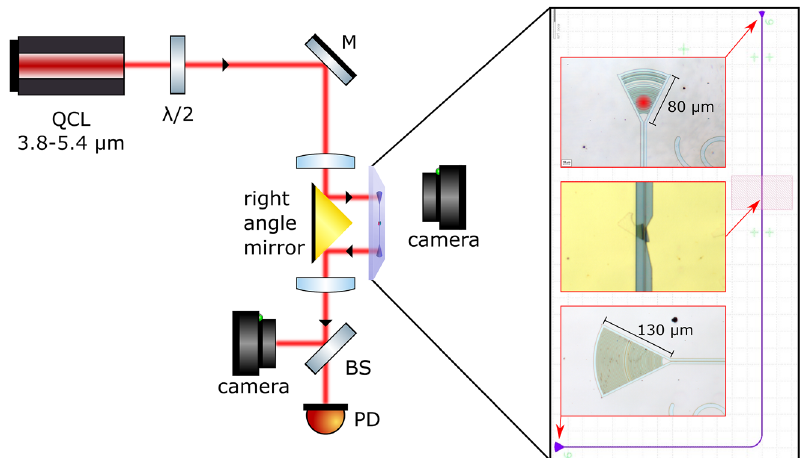
Figure 2: Experimental setup. The inset shows an overview of the waveguide layout and optical images of the grating couplers andthedevice.Theredspotinthetopoptical image represents the size of the input beam. QCL, quantum cascade laser; 𝜆 /2, half-wave plate; M, mirror; BS, beam-splitter; and PD,